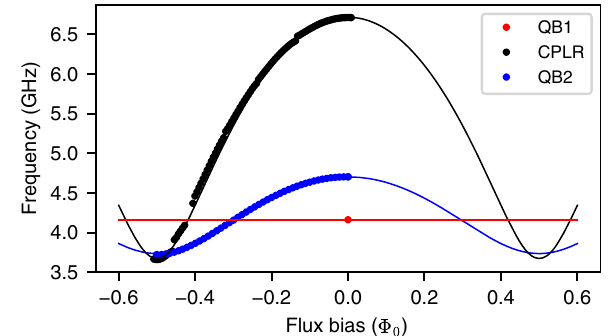
FIG. 7. j 0 i → j 1 i transition frequencies of the qubits (red and blue) and the coupler (black). Circles correspond to experimental data. Solid curves correspond to simulations based =h ¼ 12 . 2 GHz and on the fitted circuit parameters: QB1 ( E J =h ¼ 0 . 195 GHz), CPLR ( E 1 =h ¼ 46 GHz, E 2 =h ¼ 25 GHz, E c J J =h ¼ 0 . 085 GHz), and QB2 ( E 1 =h ¼ 13 GHz, E 2 =h ¼ and E c J J 2 . 8 GHz, and E =h ¼ 0 . 19 GHz), where E and E denote c J c